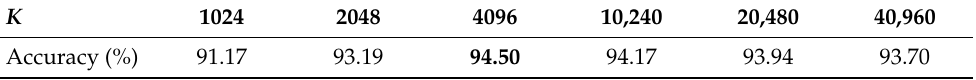
Table 11. Comparison of different dimension size ( K ) using the ViT-S/16 backbone.